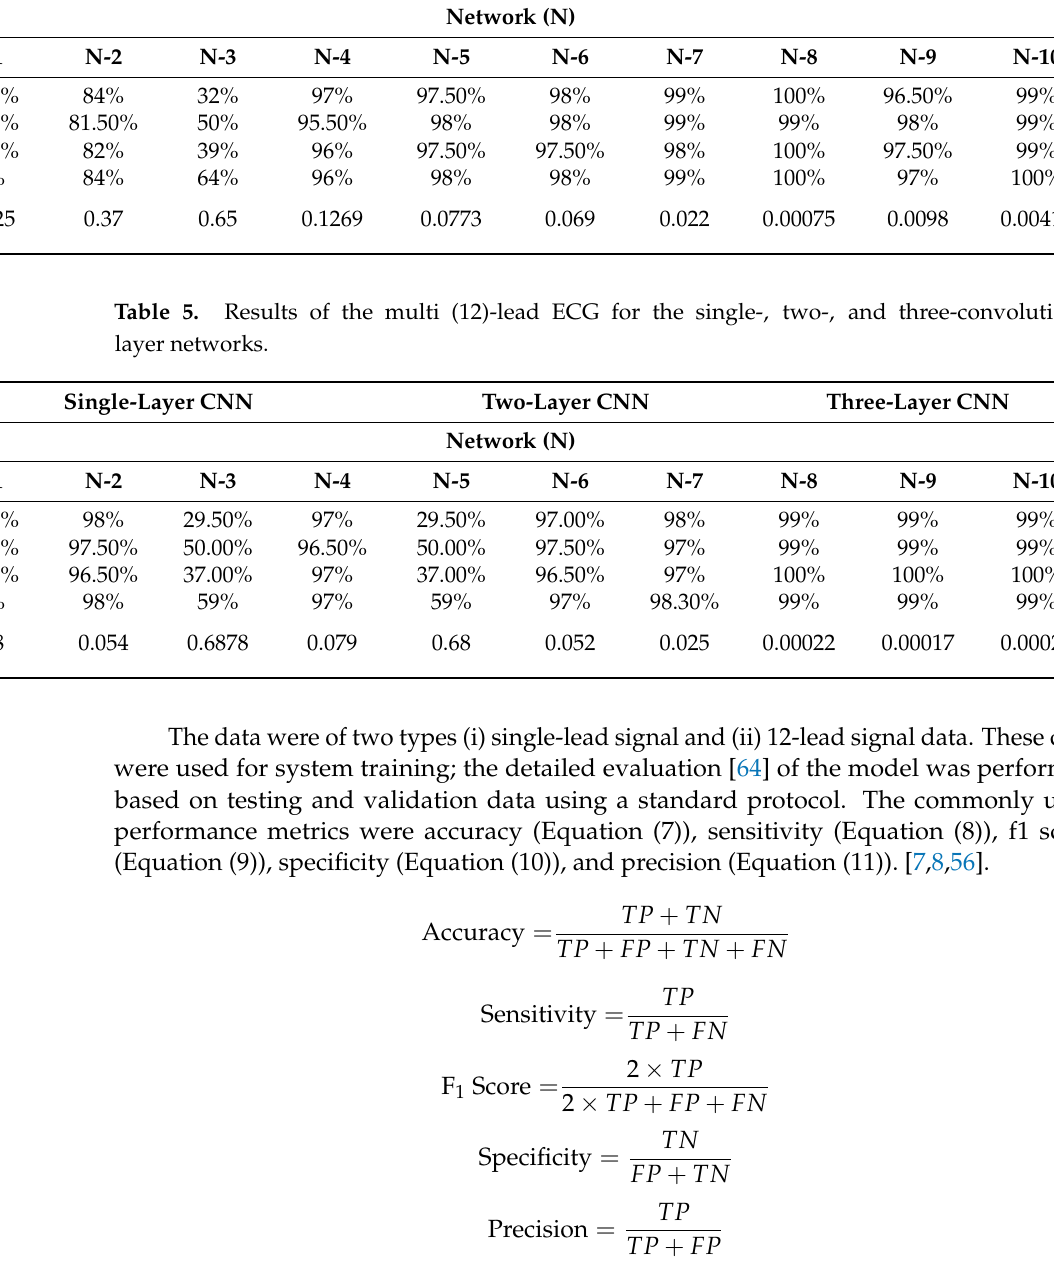
Table 4. Results of the single-lead ECG for the single-, two-, and three-convolutional layer networks. Single-Layer CNN Two-Layer CNN